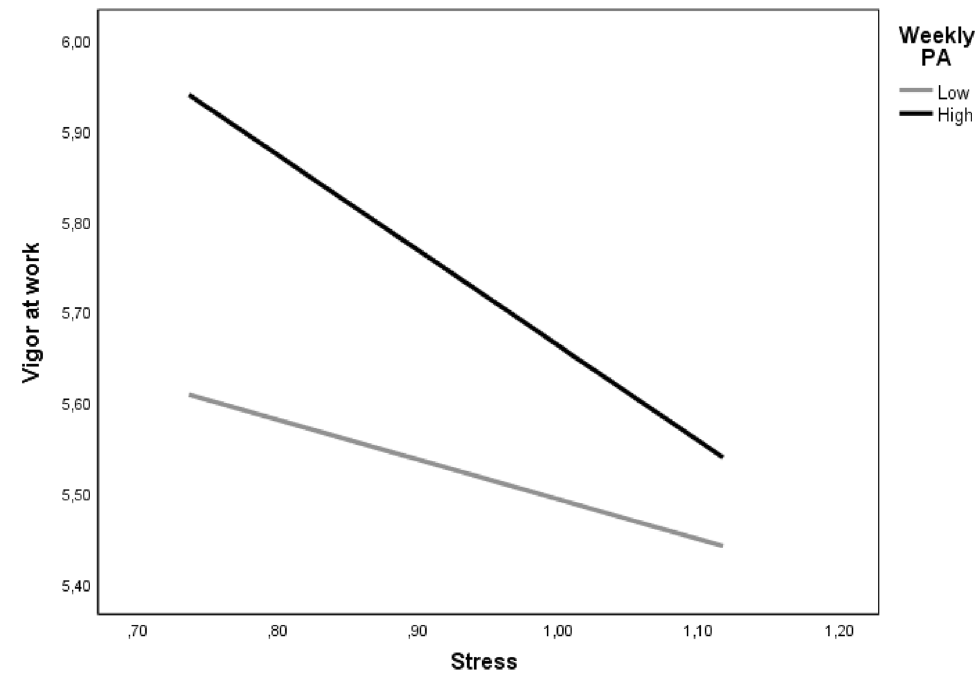
Figure 2. Moderated effect of Weekly